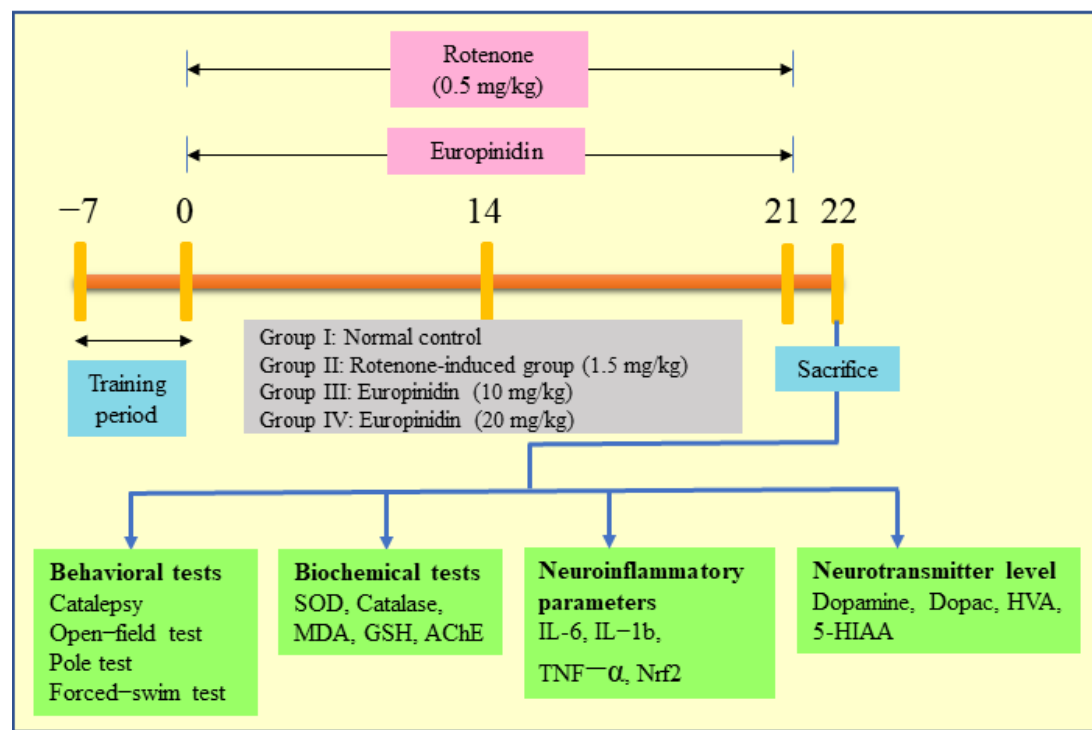
Figure 6. Brief presentation of the experimental protocol.